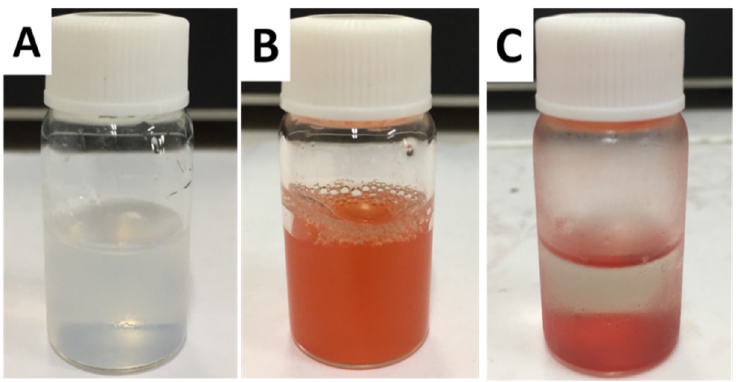
Figure 3. The SiO 2 NPs solutions before ( A ); freshly prepared and stay-for-some-time DOX·HCl-SiO 2 NPs ( B , C ).